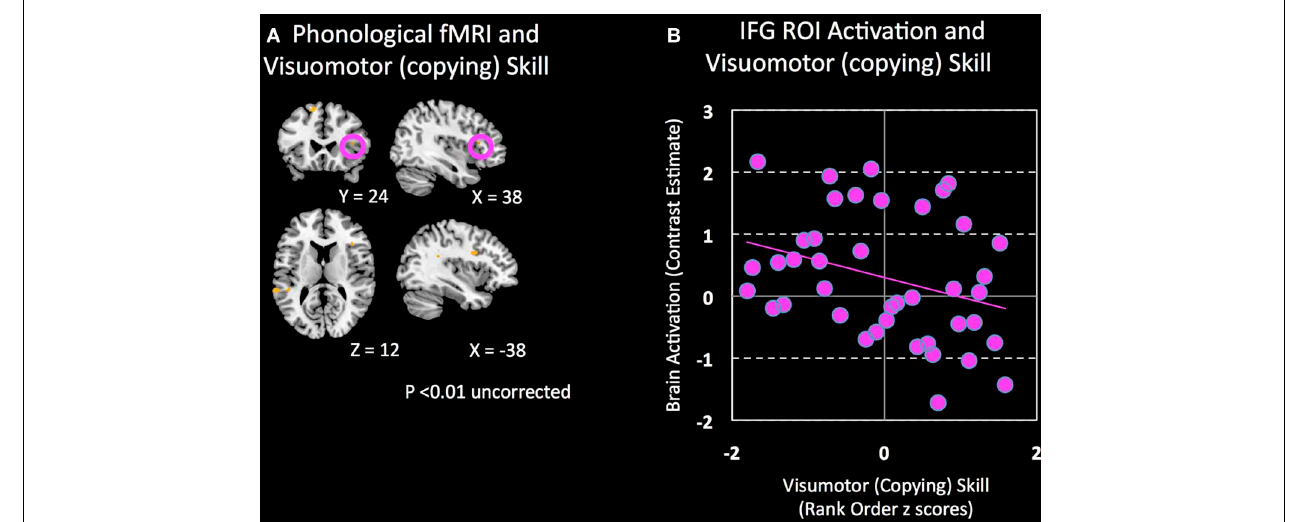
FIGURE 4 | Brain regions associated with visuomotor (copying) skill. (A) Clusters that show a negative association ( p = 0 . 01 uncorrected) between visuomotor (copying) skill and brain activation during a phonological